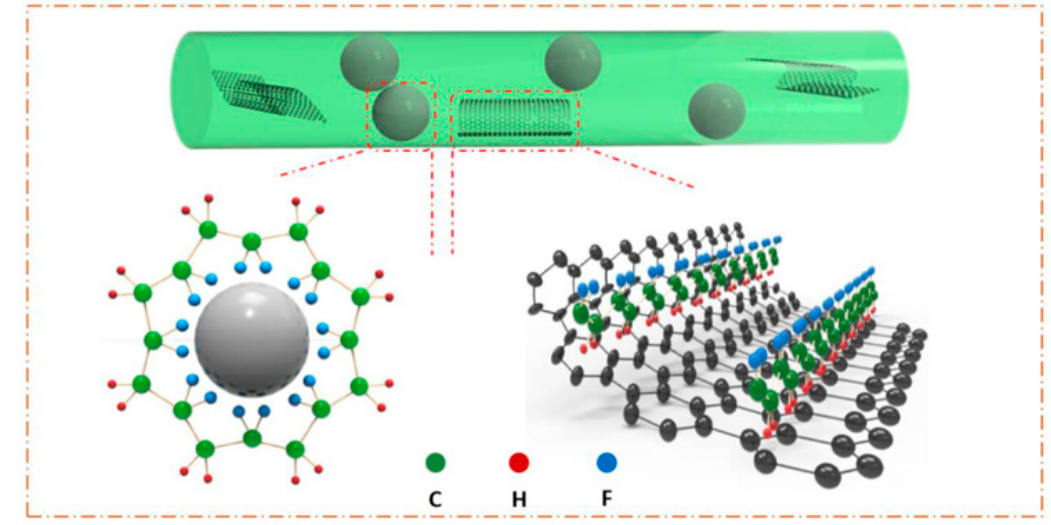
Figure 11. The mechanism diagram of β -phase formation on barium titanate (BT) nanoparticles and graphene nanosheets in the nanocomposite fiber. Reprinted with permission from [107].